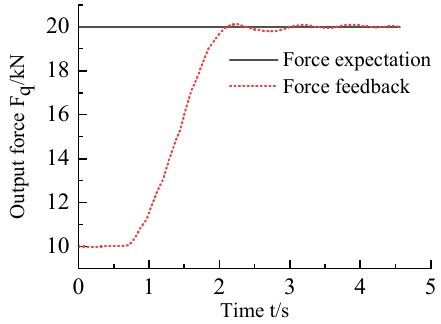
Figure 21. Response curve of step force.